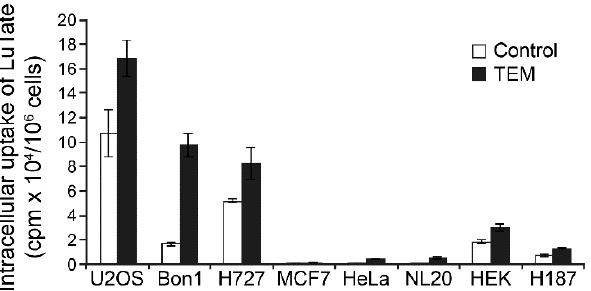
Figure 6. Variable response of NET, other cancers and non-cancer cell lines to TEM-induced changes in LuTate uptake. The TEM-induced changes in uptake of LuTate by NET cell lines BON-1 and NCI-H727 was compared with other cancer cell lines, such as U2OS (osteosarcoma), HeLa (cervical cancer), MCF7 (breast cancer) and H187 (small cell lung cancer), as well as with two normal cell lines NL-20 (normal bronchial epithelial), and HEK (human embryonic kidney). The cells seeded